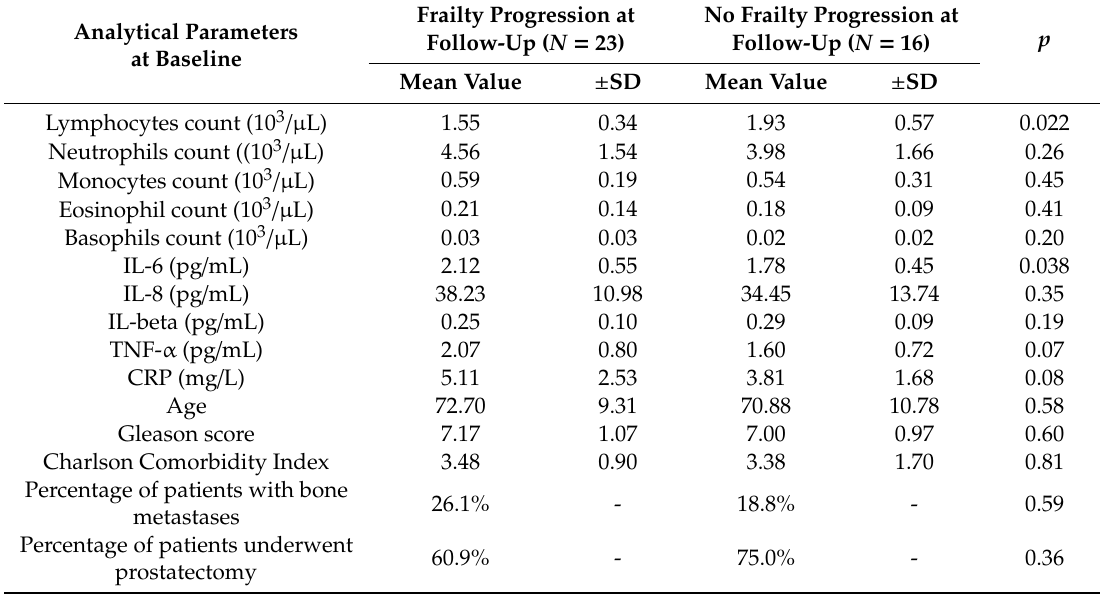
Table 2. Inflammatory markers and frailty progression at follow-up.